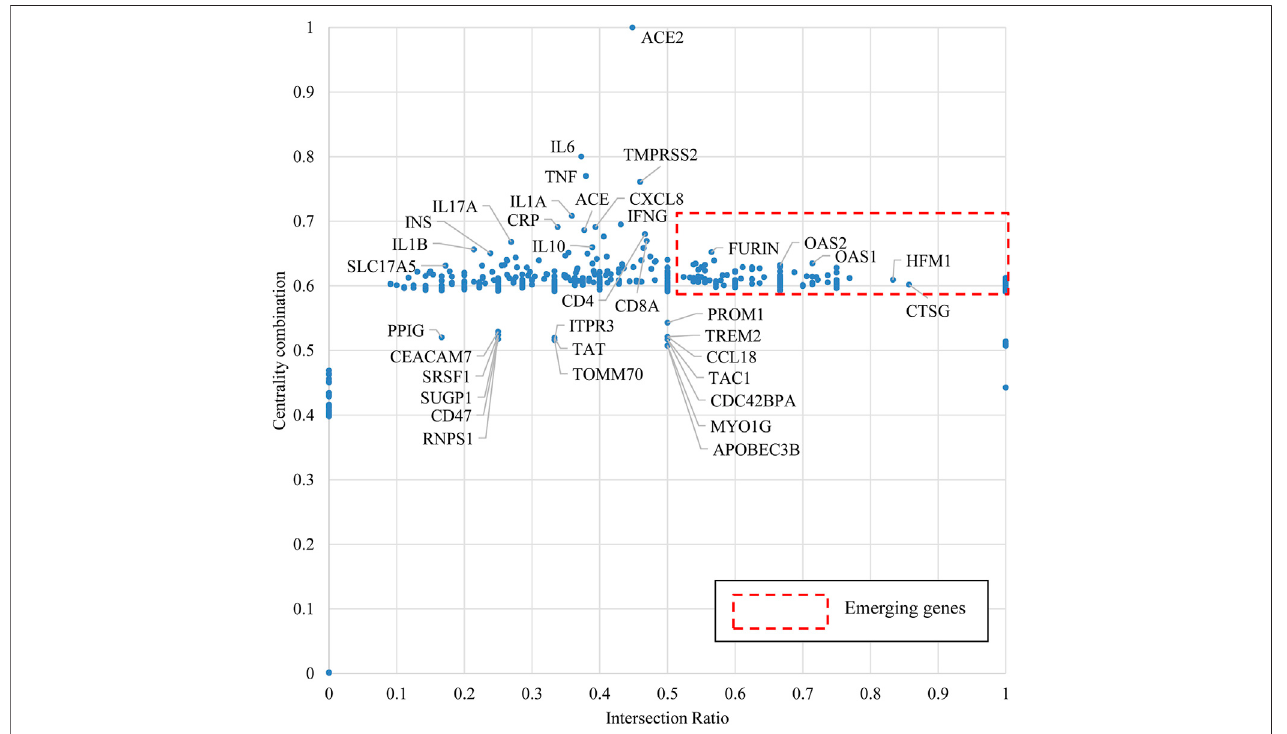
FIGURE 7 | Emerging gene discovery for COVID-19 genetic